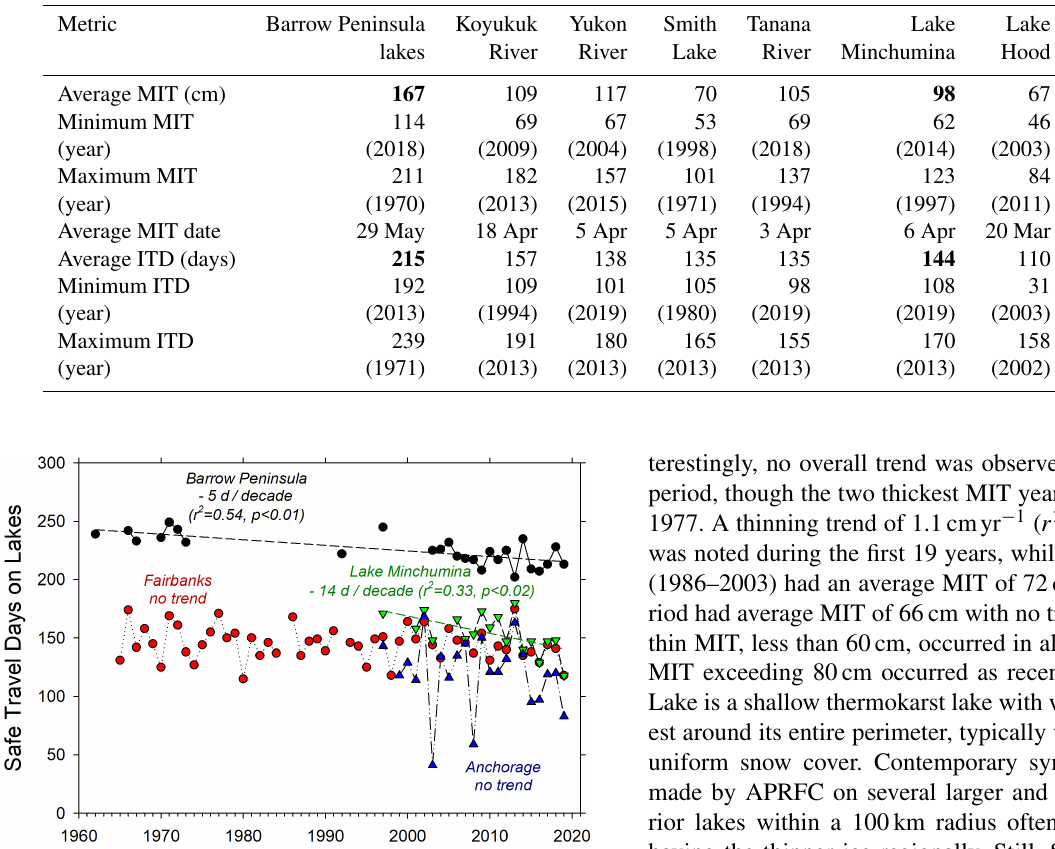
Table 2. Summary of maximum ice thickness (MIT) and ice travel duration (ITD) according to the mean, minimum, and maximum values for each period of record reported here by nearest community to observed lakes and rivers. Years corresponding to minimums and maximums are in parentheses, and metrics with significant trends are in bold.